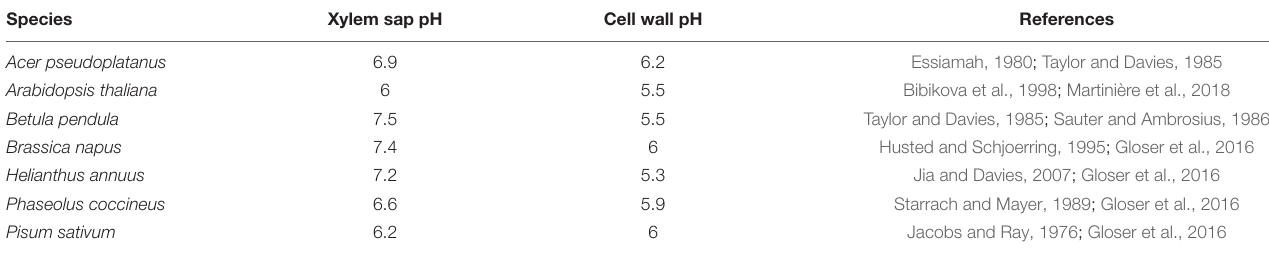
TABLE 3 | Xylem sap and cell wall pH in different plant species. Species Xylem sap